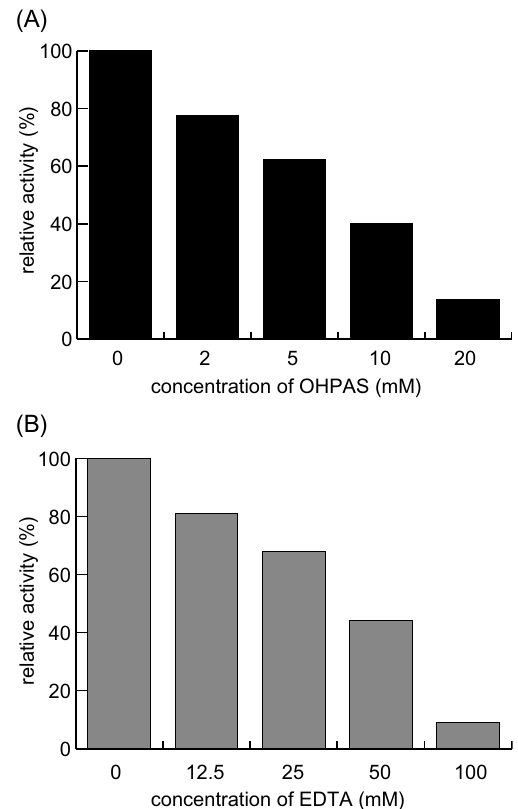
Figure 6. Inhibition of the vanillin reduction activity of rCaCAD1 by OHPAS and EDTA. Inhibition of the vanillin reduction activity of rCaCAD1 by 0–20 mM OHPAS ( A ) and 0–100 mM EDTA ( B ). The amount